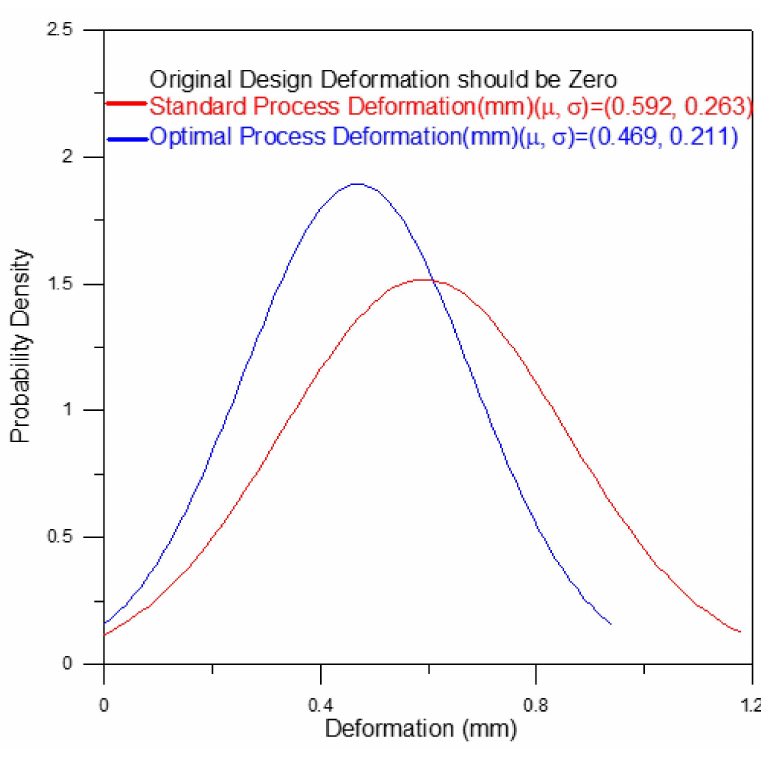
Figure 14. Deformation improvement of the optimal process compared to the standard process. Table 4. The analyzed results of Roundness and Concentricity are on the four measured planes. Least Square Circles Measured Unit: Mm Planes